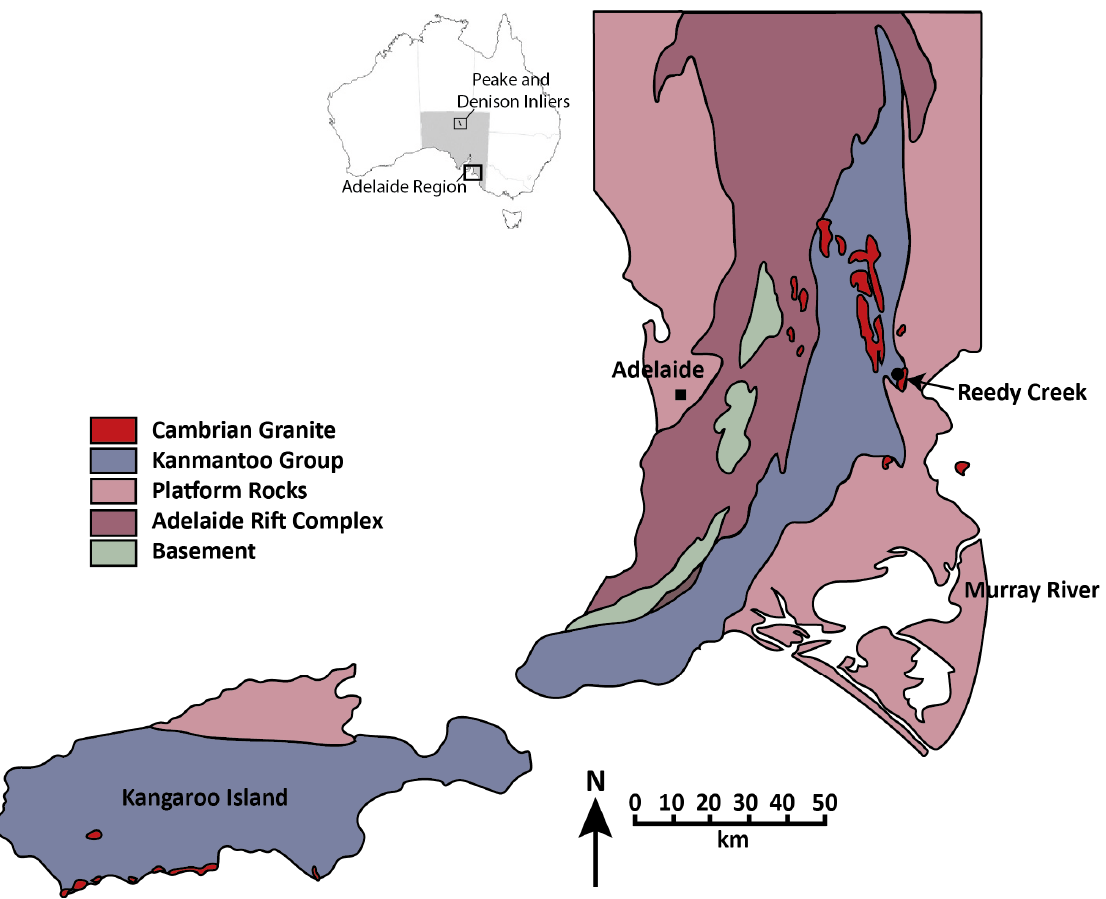
Figure 1. Detail of the geology in the Delamerian Orogen as seen in the southern Adelaide Fold Belt. After Foden et al . [27].